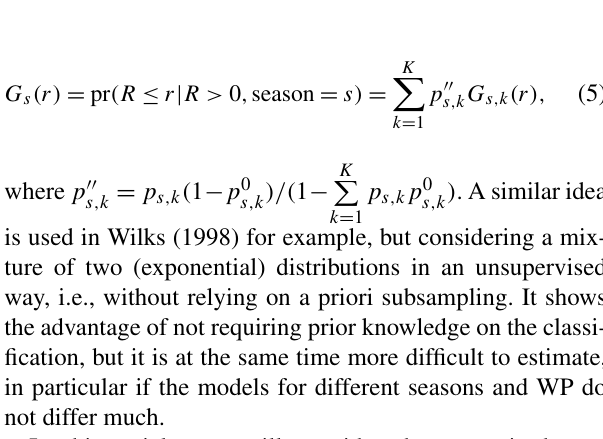
is assigned to a WP. If S seasons and K WP are